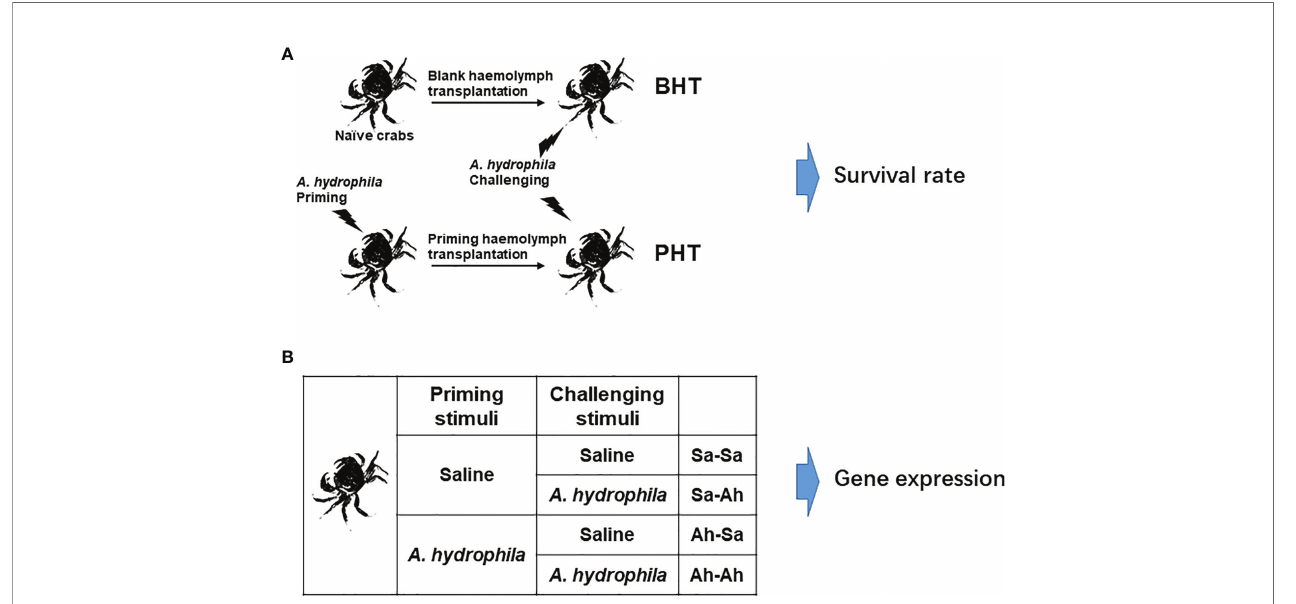
FIGURE 1 | Experimental design. (A) A. hydrophila priming stimulation and haemolymph transfer. The crabs were primed by individually injecting with A. hydrophila and the haemolymph was sampled at 7 days (Ah-7d) post injection. Then cell-free haemolymph collected from Ah-7d crabs (priming haemolymph) and blank crabs (blank haemolymph) was transferred to the recipient, and seven days later the crabs were challenged by A. hydrophila injection. Then the survival rate of crabs (N=25) in each group was statistically recorded to 84 h. (B) The twice stimulation experiment in crab E. sinensis . The crabs were separated into 4 groups. The crabs in the Ah-Sa and Ah-Ah groups were fi rst primed by 100 m L low dose A. hydrophila (6×10 6 CFU mL -1 ) stimulation, while the crabs in the Sa-Ah and Sa-Sa groups received injections with saline as control. Then, 7 days later, the crabs in the Ah-Ah and Sa-Ah groups received A. hydrophila (6×10 7 CFU mL -1 ) challenging stimulation, while the crabs in the Ah-Sa and Sa-Sa groups received injection with saline as control. At 12 h post the second injection, the haemolymph of crabs from the four groups (Sa-Ah, Ah-Ah, Sa-Sa, Ah-Sa) was collected for analysis. (Sa, saline; Ah, A. hydrophila ; the fi rst two letters mean priming regent, while the two latter letters mean challenging